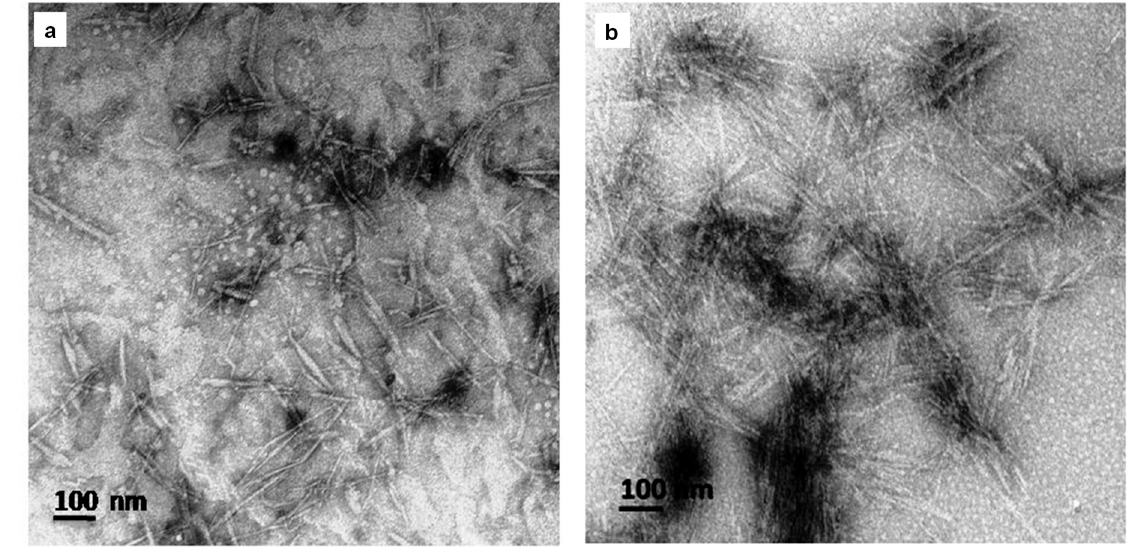
Figure 5. Transmission electron microscopy (TEM) images of ( a ) CNCs and ( b ) TMX-CNCs.